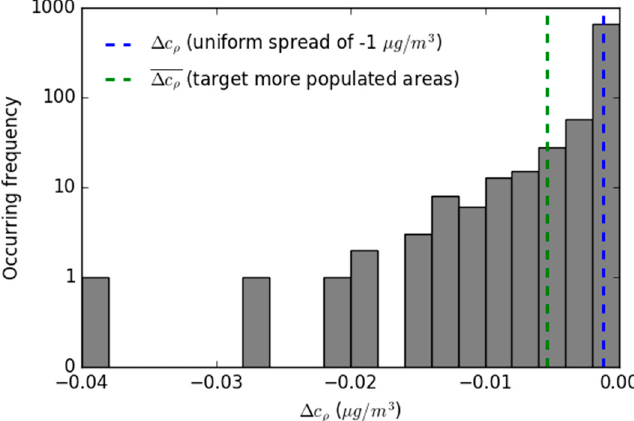
Figure 4. Frequency distribution of ∆ c ρ of Hong Kong among the 804 tests. The blue-dashed line represents ∆ c ρ when uniformly reducing PM 2.5 concentration. The green-dashed line shows mean ∆ c ρ when PM 2.5 reduction targets more populated areas.